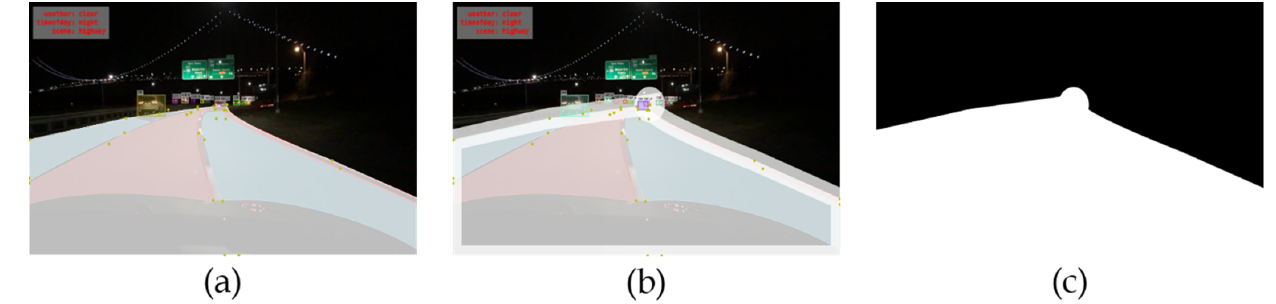
Figure 13. RoI bounding boxes filter generating flow: ( a ) the two sides of lane lines, the vanishing point, and the bottom boundary of the image to enclose a region, ( b ) the RoI is dilated with 50 pixels, and the vanishing point circle is using a radius of 50 pixels, ( c ) the generated bounding boxes RoI mask.